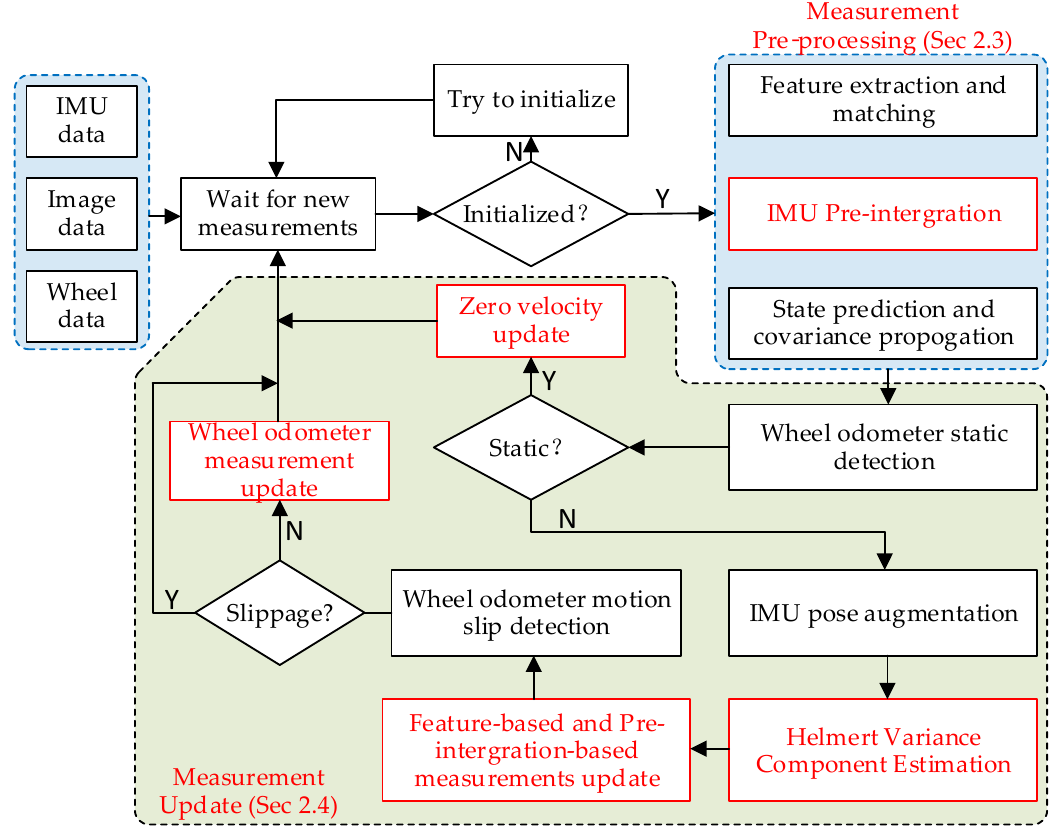
Figure 1. The system framework.